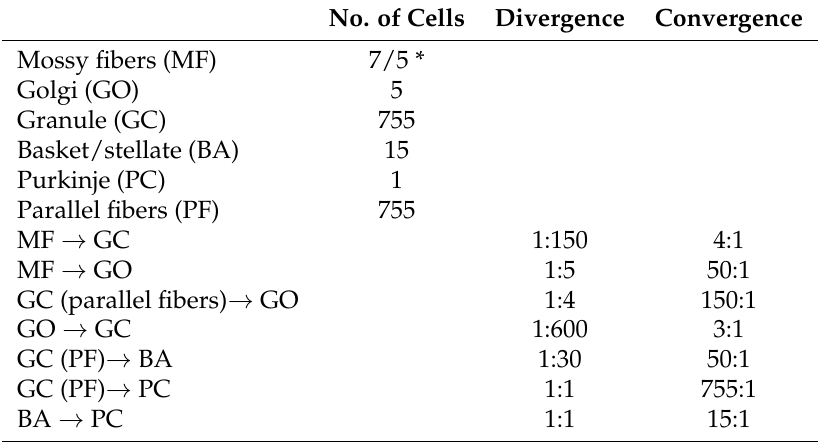
Table 1. Convergence and divergence synaptic ratio in the CNN (cerebellar neuronal network) model.